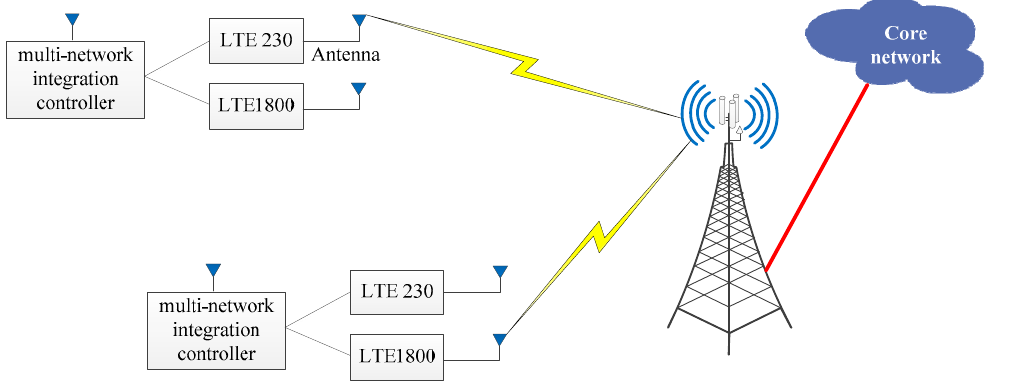
Figure 10. An illustration of integration of the access network with a multinetwork integration controller.